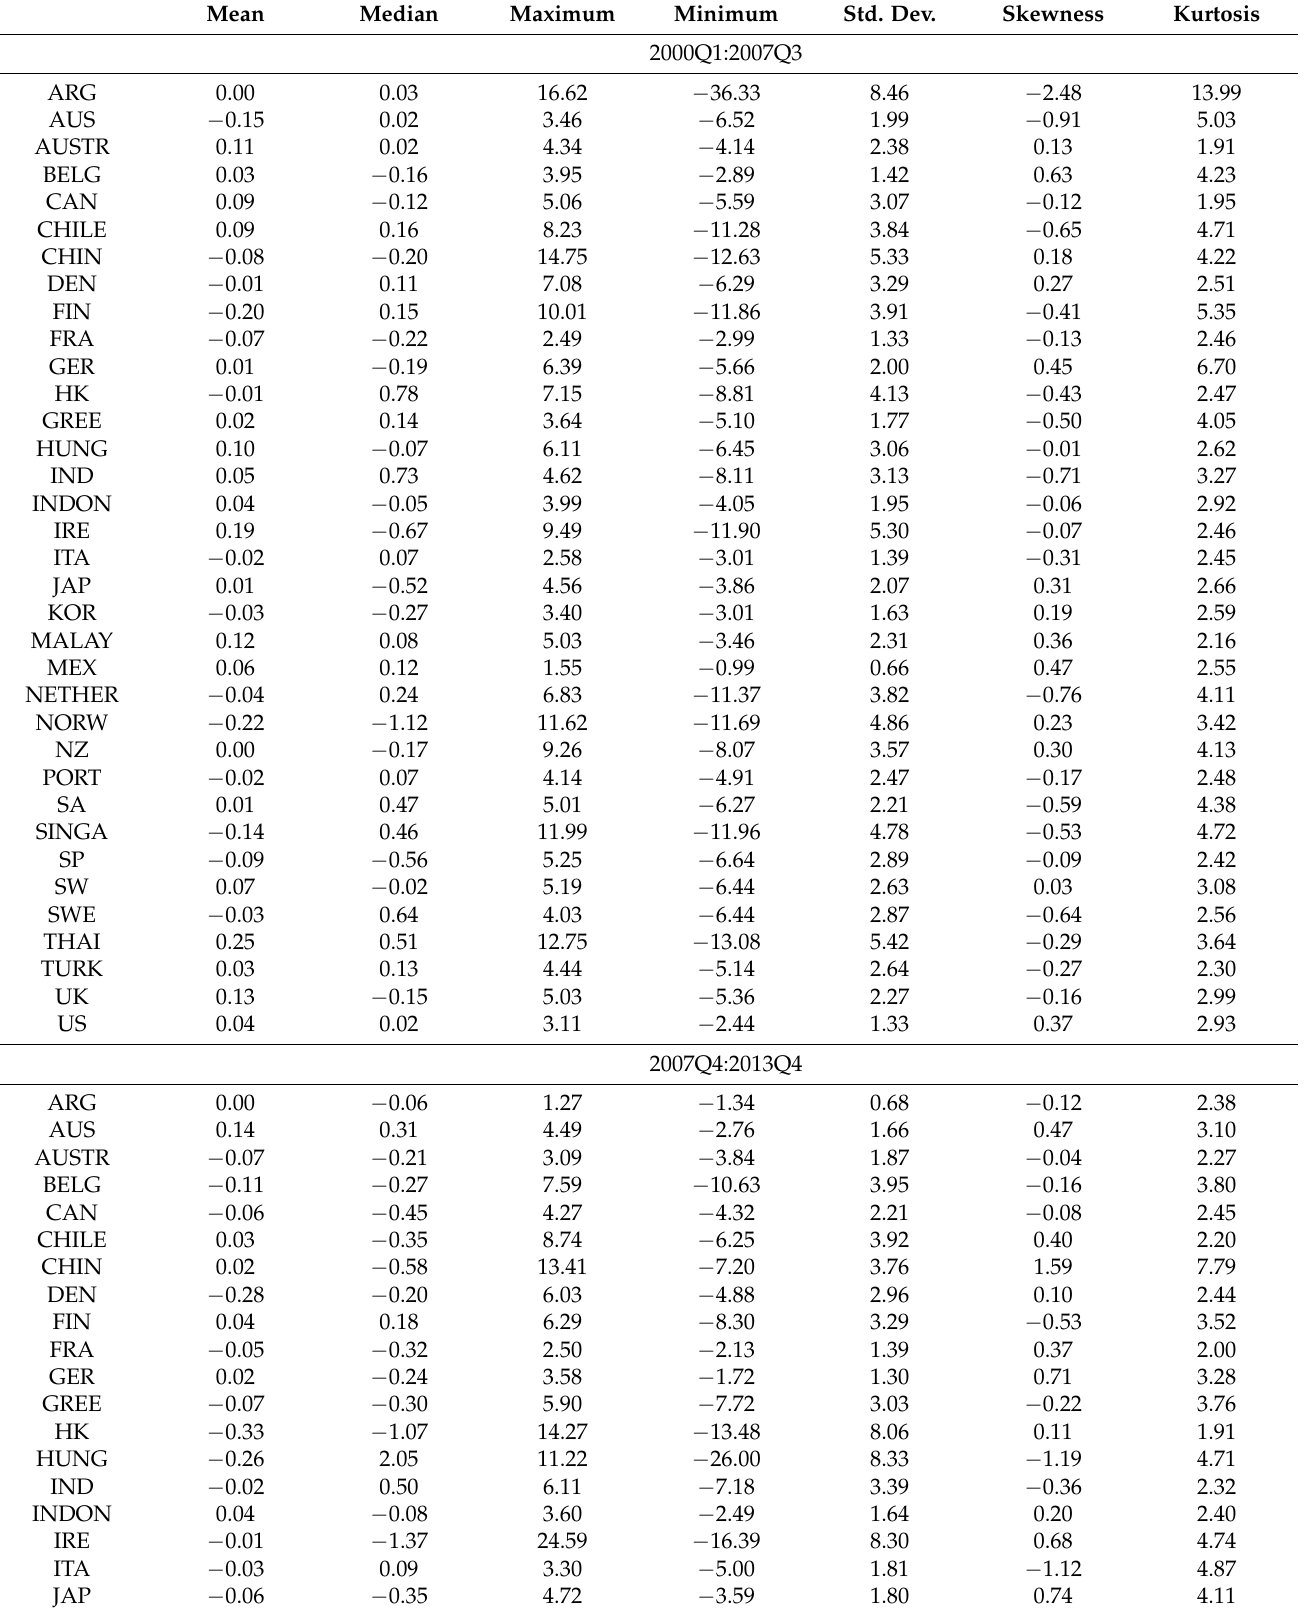
Table A2. Descriptive statistics for national credit-to-GDP